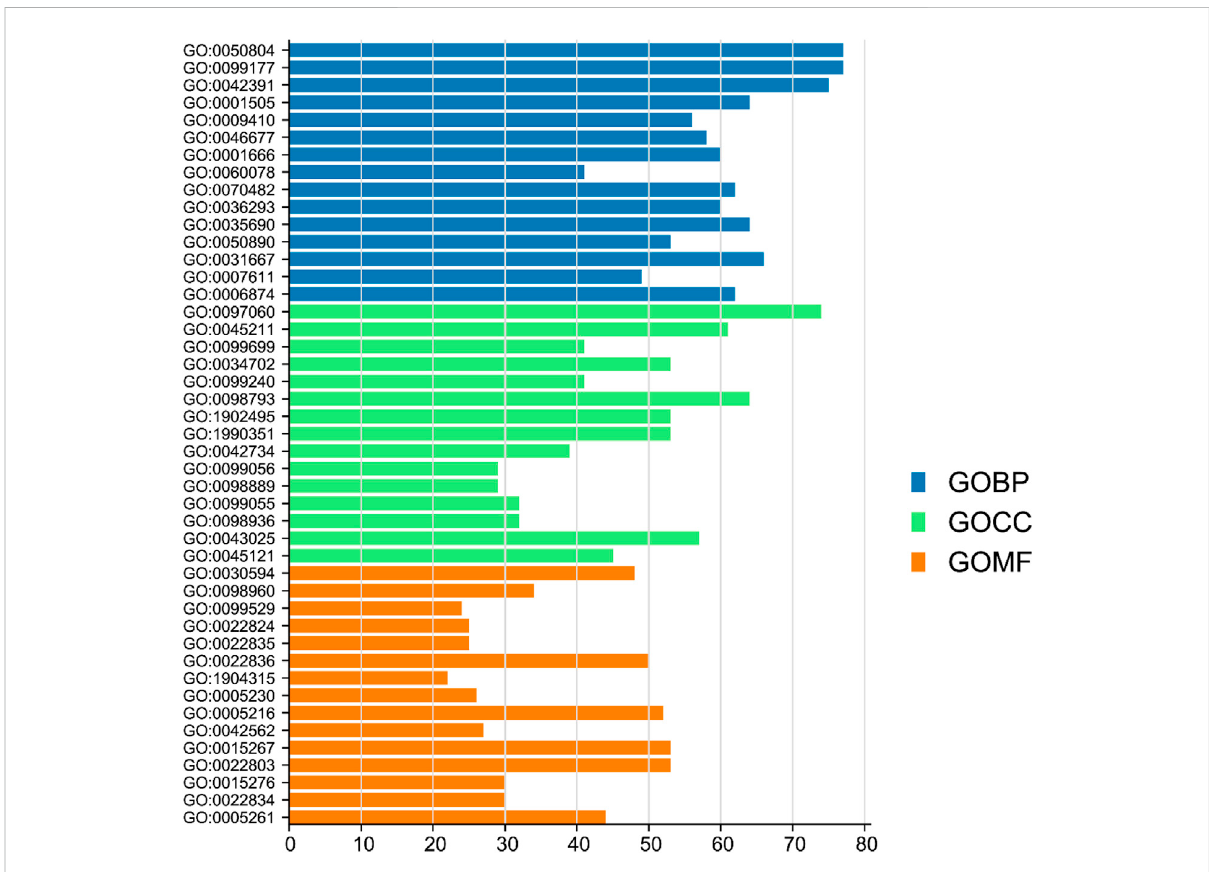
FIGURE 8 Go enrichment analysis of the targets of FCG. FCG, functional components